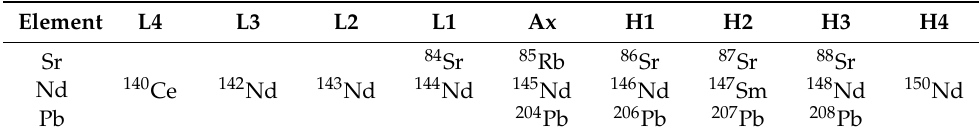
Table 2. Cup configuration for Sr–Nd–Pb isotope analysis.